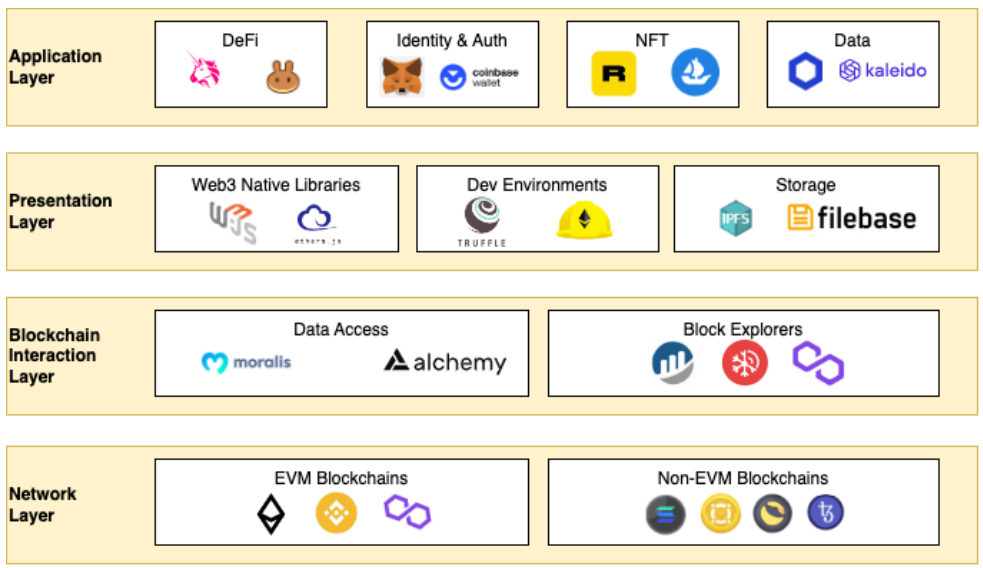
Figure 1. Blockchain application